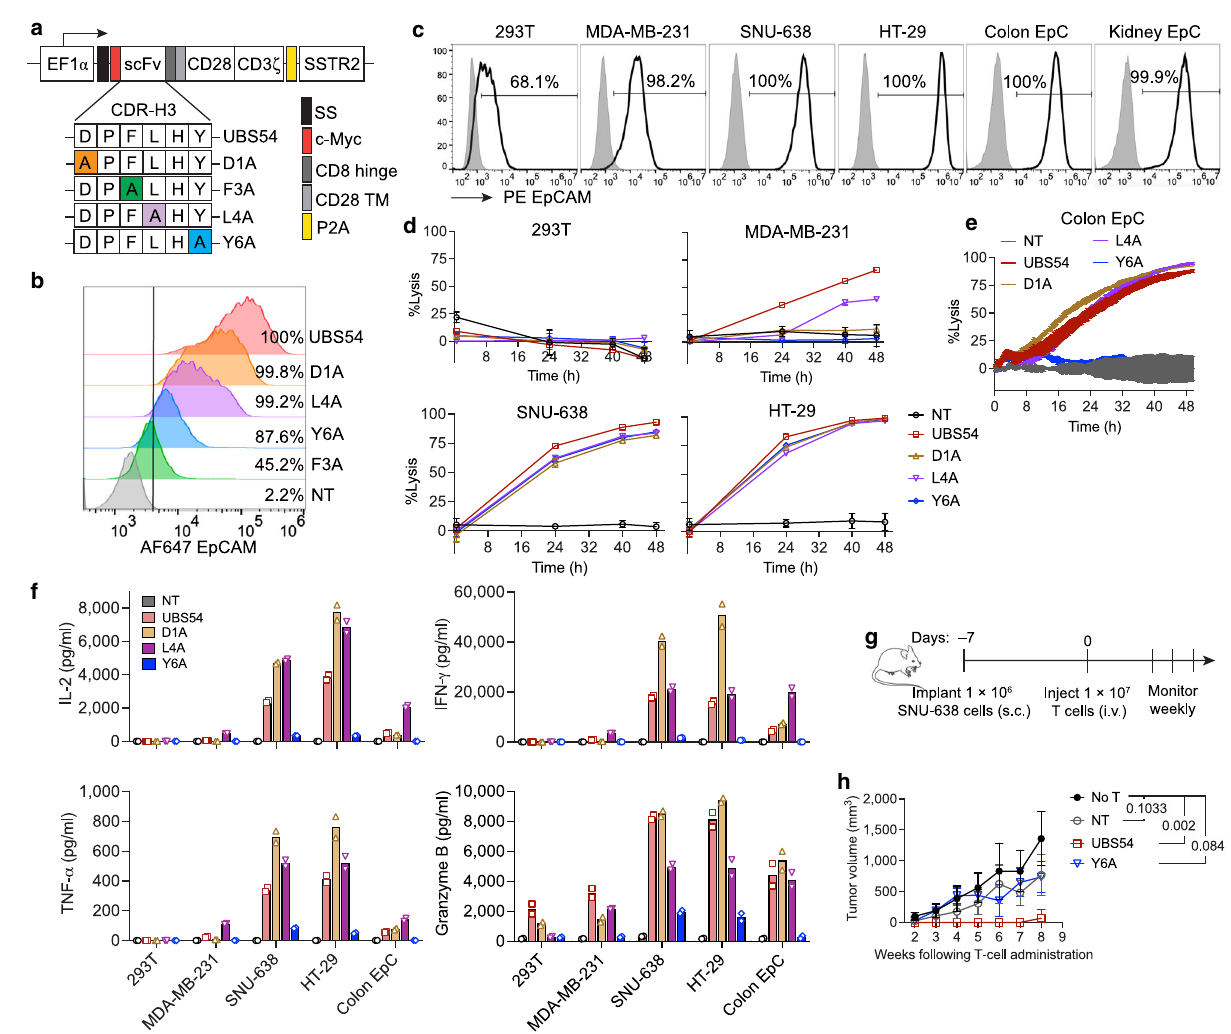
Fig.1|AlaninescanningmutagenesisinCDR-H3ofUBS54scFvidenti fi esY6as a critical residue for af fi nity-tuning. a Schematic representation of the lentiviral vector encoding EpCAM CAR variants. Alanine scanning mutagenesis was per- formed on 4 amino acid residues in CDR-H3 region of the UBS54 scFv: D1A, F3A, L4A and Y6A. Coding sequences of scFv variants were inserted into the 2nd gen- eration CAR construct containing CD8 hinge, transmembrane and cytoplasmic domains of CD28, and the cytoplasmicdomain ofCD3 ζ . A c-Myc tagwasplaced at theN-terminusforCARdetection. b Relativeaf fi nitiesofEpCAMCARvariantswere determined by staining CAR-expressing Jurkat cells with 300nM of AF647- conjugated monomeric EpCAM protein, using non-transduced T (NT) cells as control. c Surface expression of EpCAM in tumor cell lines and human primary epithelial cells (EpC), determined by fl ow cytometry after staining with PE anti- human EpCAM antibody. d Bioluminescence-based cytotoxicity assay using NT cells as control. e Impedance-based cytotoxicity assay measuring cytolytic